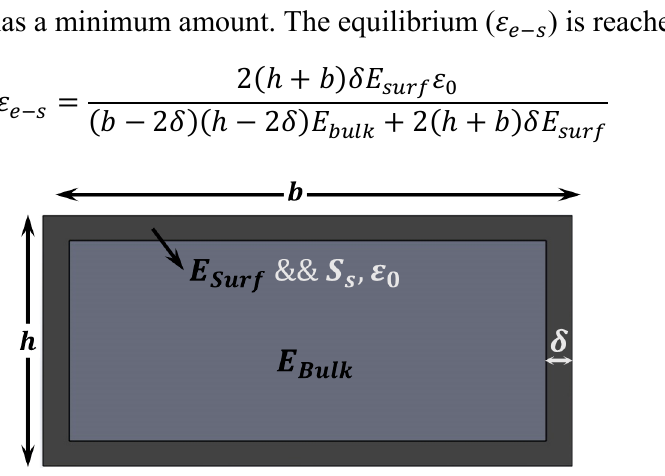
Figure 5. Surface Stress Theory (SST). Schematic showing the cross section of a layer that shows different material properties close to the surface, like in Figure 4, but in this case we also need to account for the surface